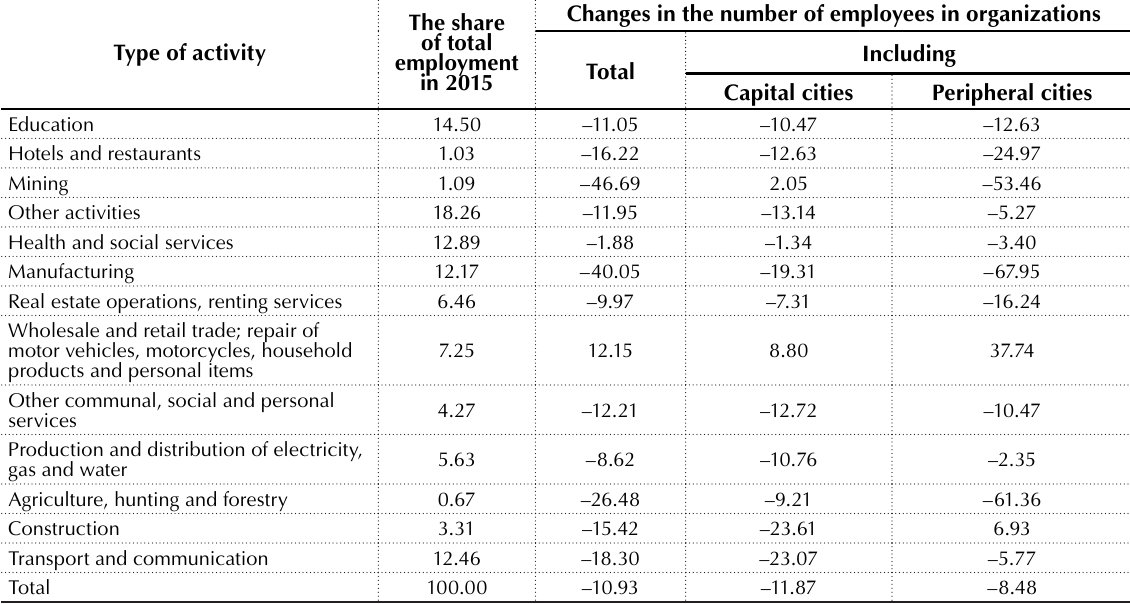
Table 4. Changes in the number of employees in organizations in cities of the North-Western Federal District, 2009–2015*,